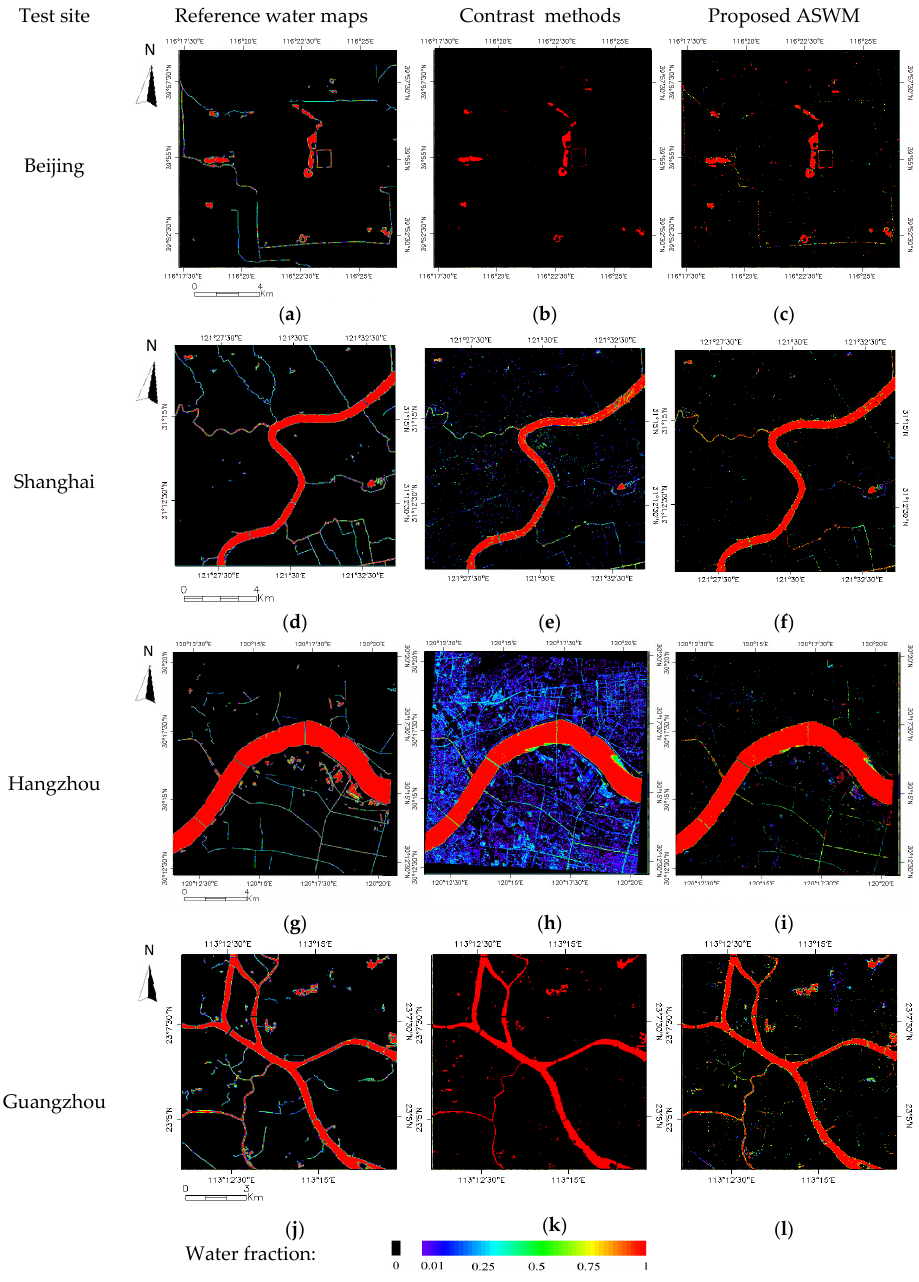
Figure 6. Comparison of the water mapping results. First row: reference map, water map from the contrast method of MNDWI, and result of the proposed method of Beijing corresponding to ( a – c ); Second row, reference map, water map from the contrast method of MESMA, and result of the proposed method of Shanghai corresponding to ( d – f ); Third row, reference map, water map from the contrast method of FCLS, and result of the proposed method of Hangzhou corresponding to ( g – i ); Fourth row, reference map, water map from the contrast method of CEM, and result of the proposed method of Guangzhou corresponding to ( j – l